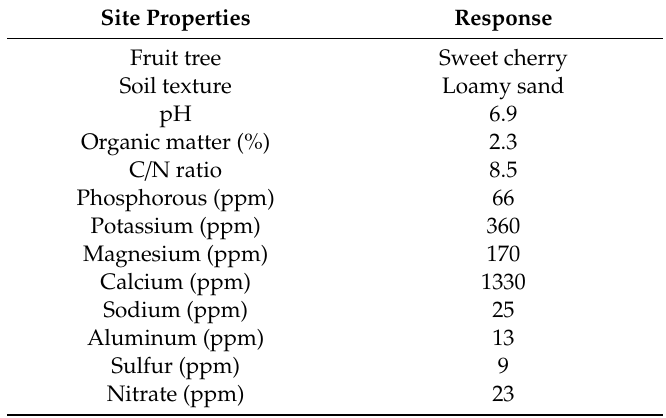
Table A2. Fertilizer application for Vitis vinifera cuttings in native and cultivar studies. Miracle-Gro fertilizer was used to prepare solutions of varying concentrations. Enough fertilizer was applied to cover the soil and soak through.